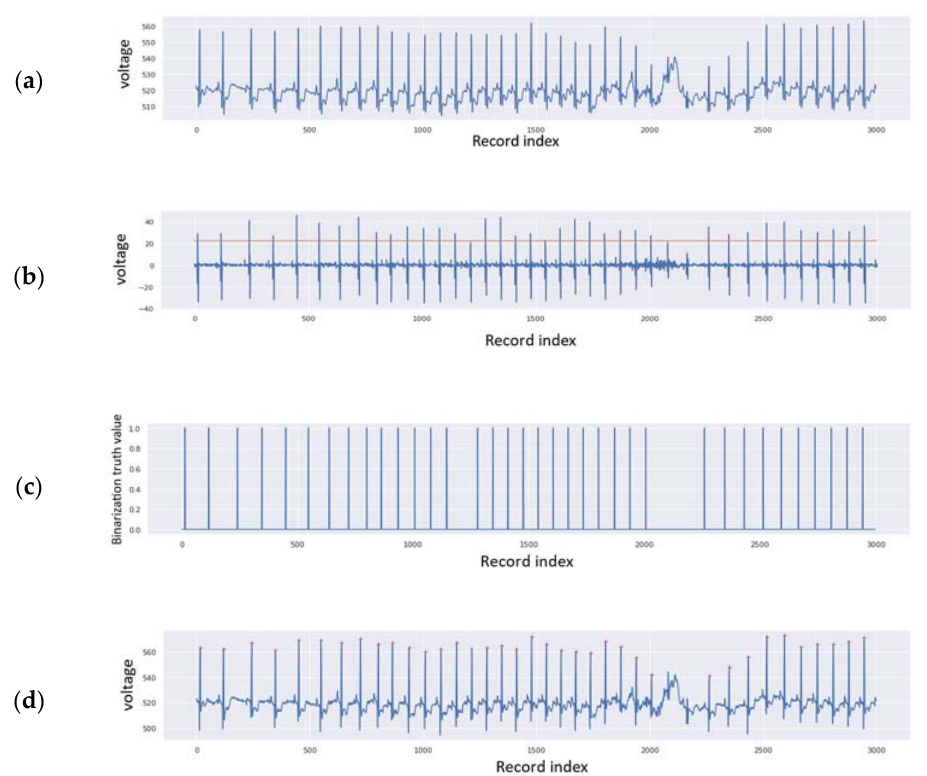
Figure 5. Pre-annotation results: ( a ) original noisy signal for testing taken from an ambulatory device (Savvy ECG); ( b ) discrete derivative of the signal (difference between sequential values) and the detected threshold; ( c ) detected R peaks; ( d ) final pre-annotation result.